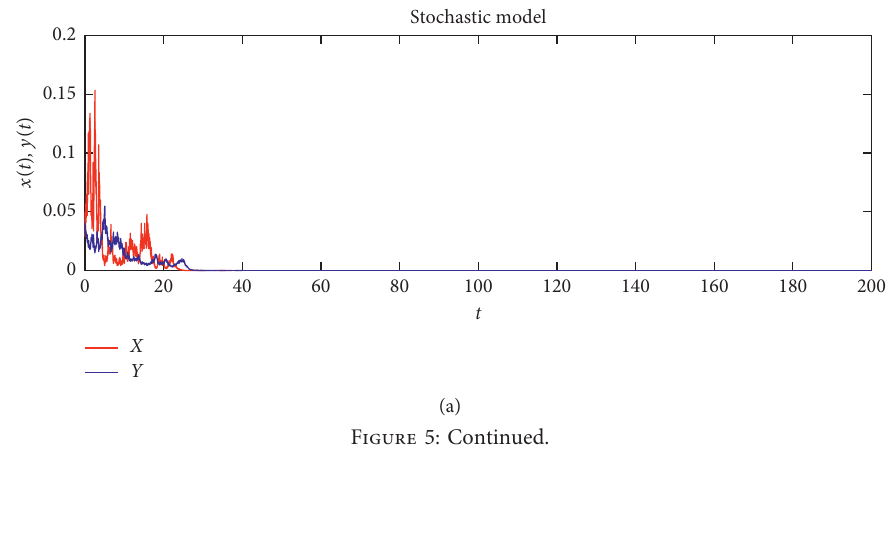
Figure 4: Computer simulations of the paths x ( t ) and y ( t ) for system (8) with the initial value ( x ( 0 ) , y ( 0 )) � ( 0 . 03 , 0 . 04 ) and σ � 0 . 1, and its corresponding deterministic model with initial value ( x ( 0 ) , y ( 0 )) � ( 0 . 03 , 0 . 04 ) σ 2